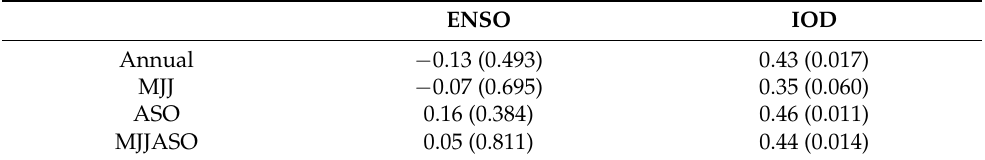
Table 2. Temporal correlation between seasonal precipitation and ENSO, and IOD during 1986–2015. ENSO IOD Annual − 0.13 (0.493) 0.43 (0.017) MJJ − 0.07 (0.695) 0.35 (0.060) ASO 0.16 (0.384) 0.46 (0.011) MJJASO 0.05 (0.811) 0.44 (0.014) Probability values are shown in